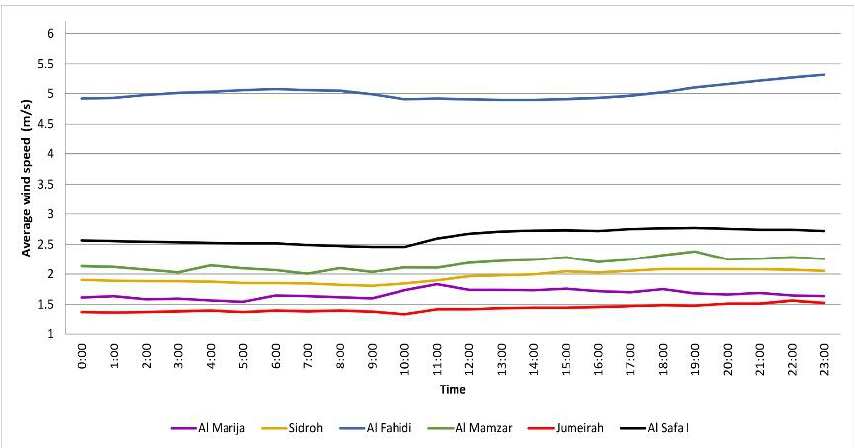
Figure 15. Hourly variations of wind speeds (m/s) for Al Marija, Sidroh, Al Fahidi, Al Mamzar, Jumeirah, and Al Safa I in April.